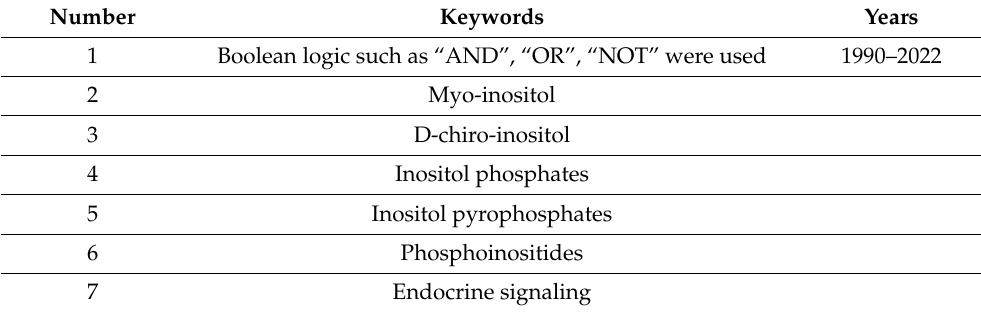
Table 1. Search review